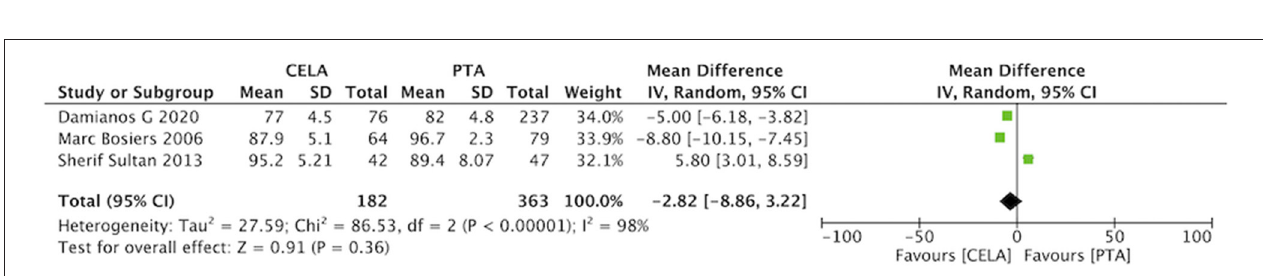
FIGURE 6 | Forest plot for amputation-free survival (AFS). Random, a randomized effects model; CI, confidence intervals. The green squares stand for the weight of studies in meta-analysis. Black rhomboid represents the effects of combination of above three studies.